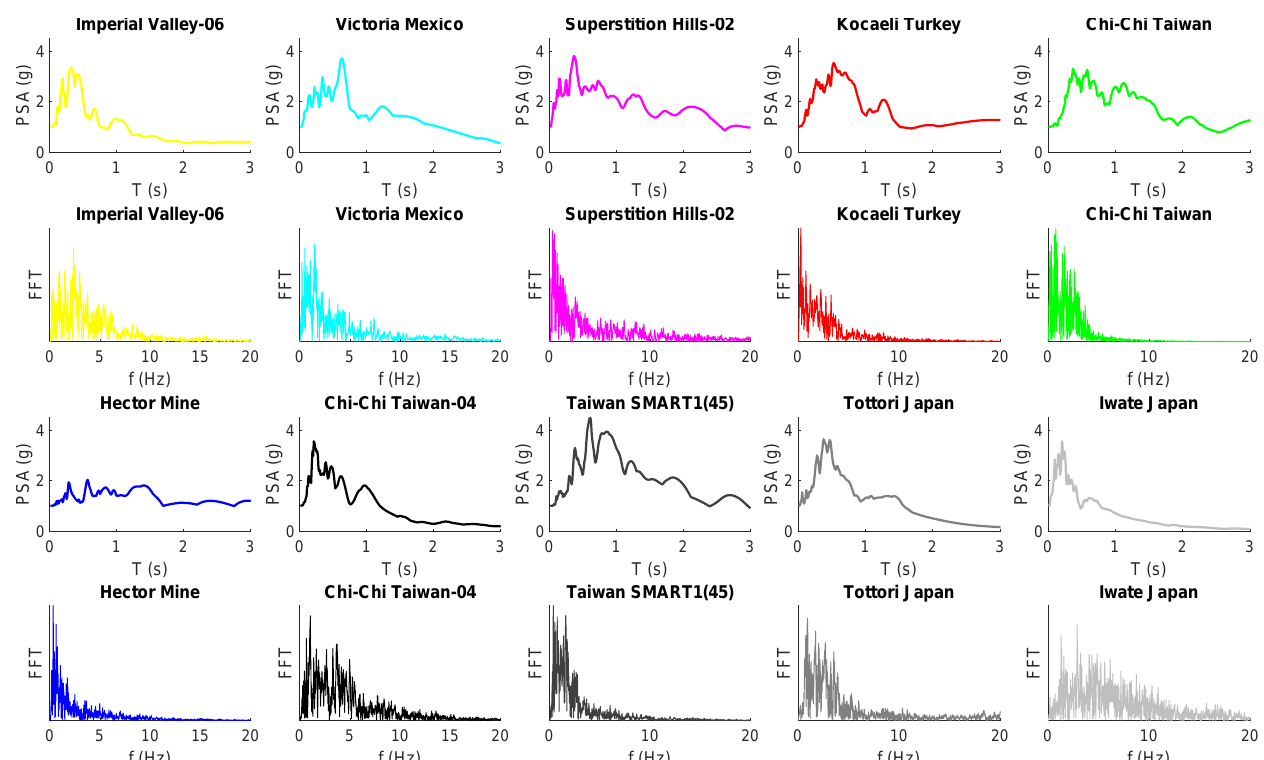
Figure 2. Normalized pseudo-spectral accelerations (PSA) and frequency content (FFT) of the accelerograms used in this